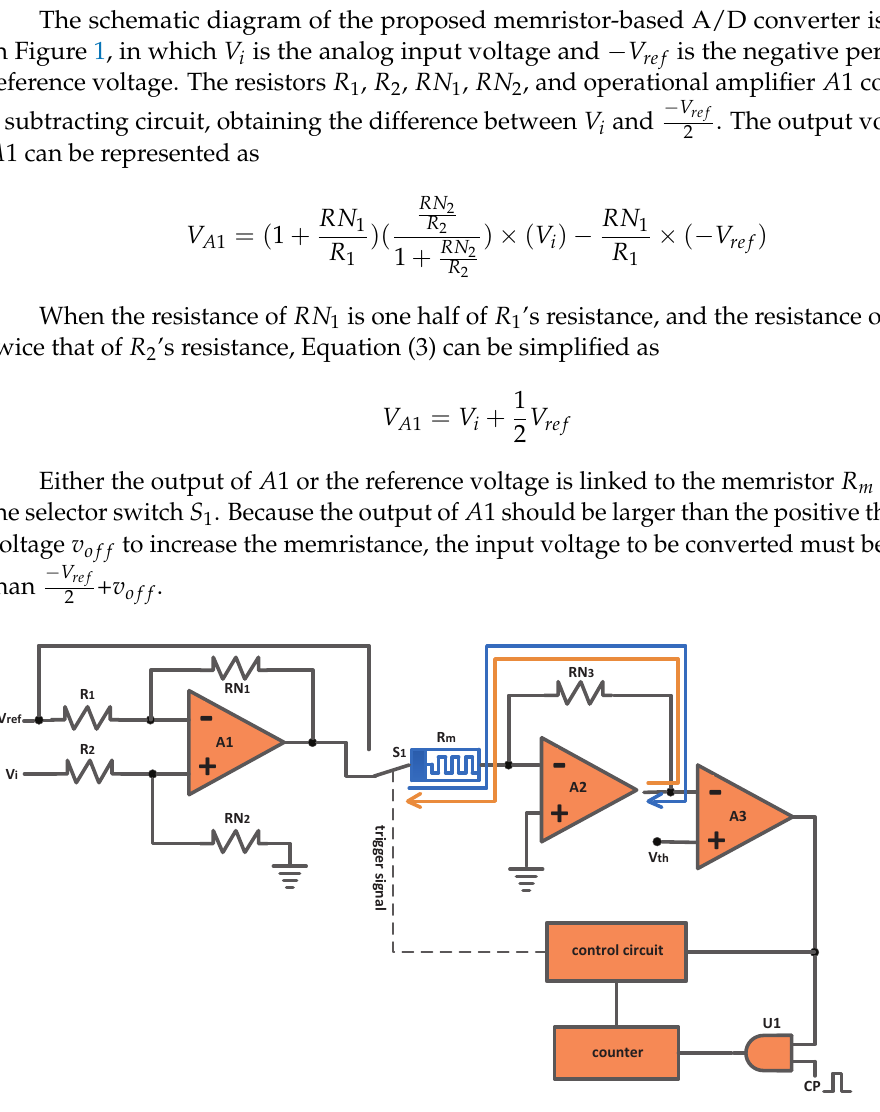
Figure 1. The schematic diagram of the memristor-based A/D converter. Memristor R m , resistor RN 3 , and operational amplifier A 2 constitute an inverting amplifying circuit. Due to virtual ground , the voltage at inverting terminal of A 2 is 0 V. When the output of A 1 is linked to the memristor, the current flows to the inverting terminal of A 2, making the memristance rise. The corresponding current path is presented as the blue line in Figure